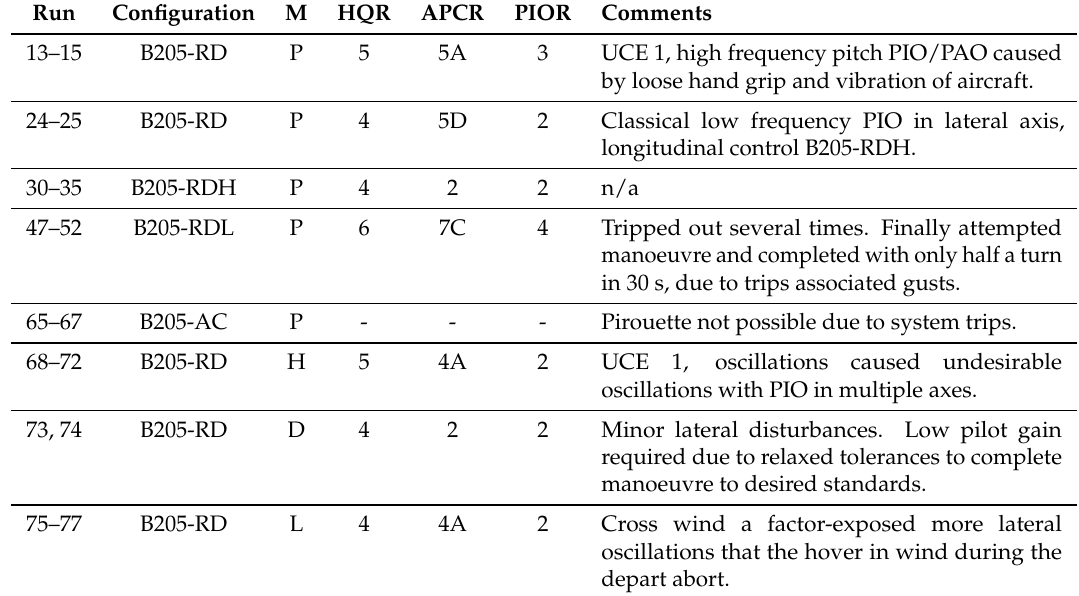
Table A1. Day 1: 4th March 2019, Aircraft Bell 205A, C-FYZV.